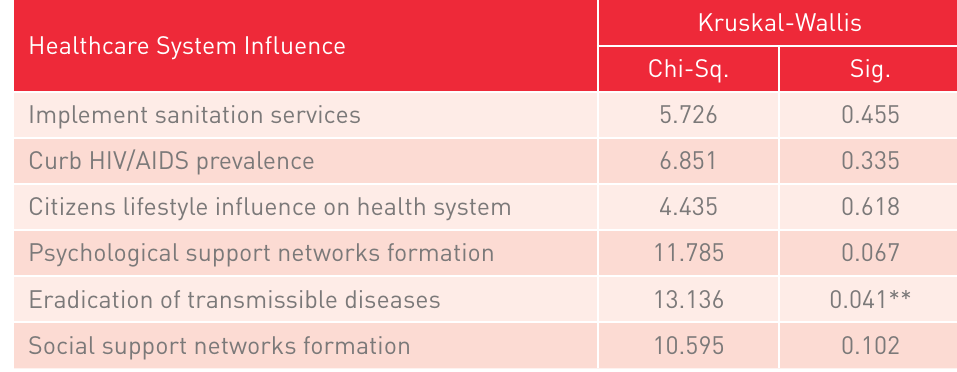
Kruskal-Wallis H-Test for Influence of Healthcare System on Resilience Healthcare System Influence